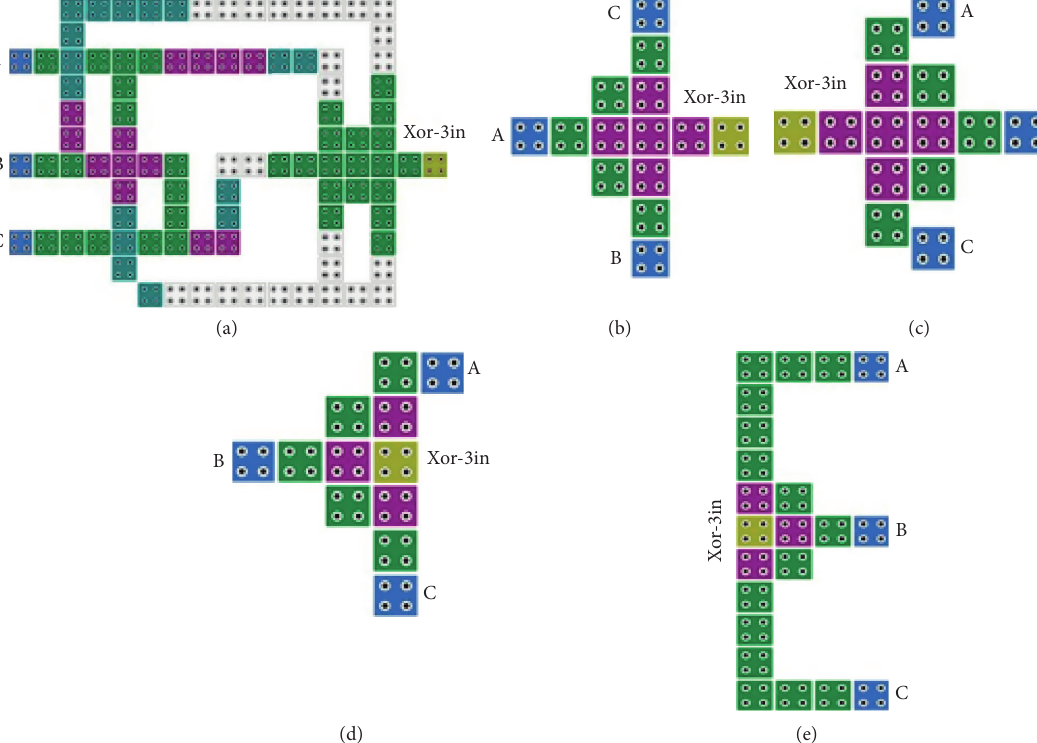
Figure 2: Previous three-input XOR gate based on QCA technology. (a) [20], (b) [21], (c) [22], (d) [23], and (e) [24].